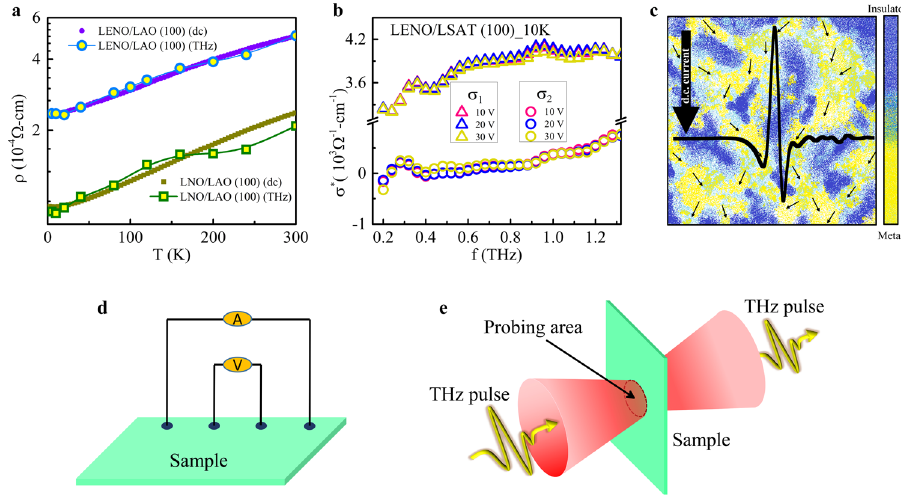
Fig. 2 Comparative representation of dc and THz resistivities, power-dependence of THz conductivity, and explanation of transport methodologies. a Comparison of resistivities obtained from DC and THz transport (at 1 THz) as a function of temperature for LNO/LAO (100) and LENO/LAO (100) fi lms. b σ (cid:2) vs f spectra with THz emitter bias voltage variation for LENO/LAST (100) fi lm at 10 K. c The schematic representation of phase-separated state consisting of insulating and metallic clusters. The small black arrows depict how the charge carriers get scattered in insulating clusters or trapped in defects in DC transport, whereas the THz waveform gives a nearly similar average transmission in the local limit. d , e Schematic representation of DC and THz transport methodology,